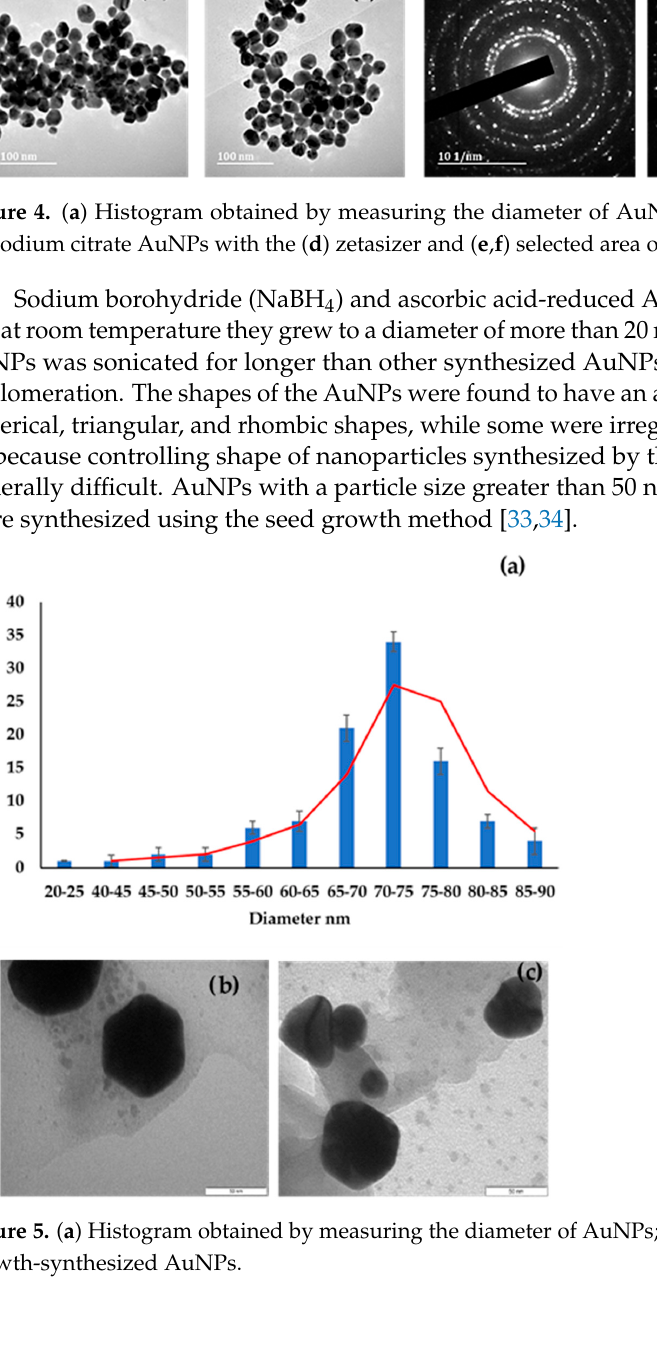
Figure 5. ( a ) Histogram obtained by measuring the diameter of AuNPs; ( b , c ) HRTEM images of seed growth ‐ synthesized AuNPs